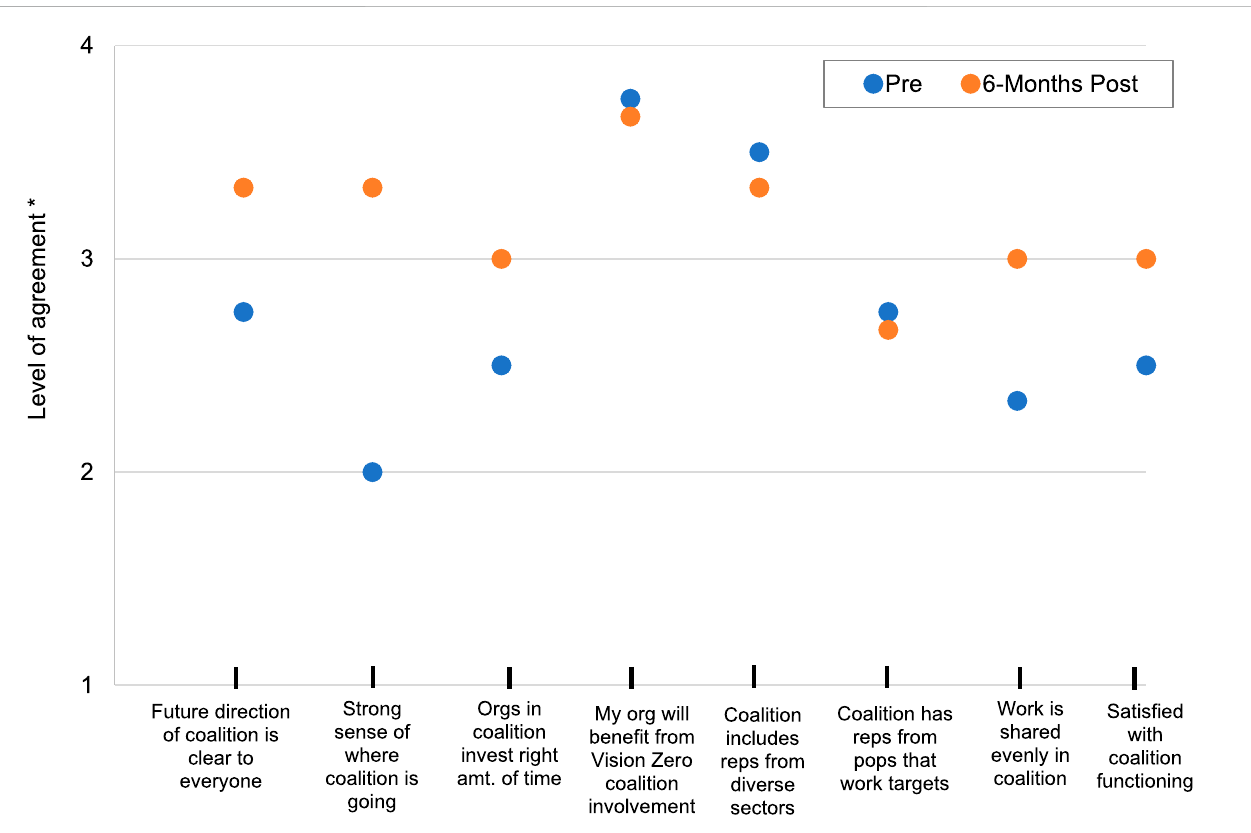
Frontiers in Future